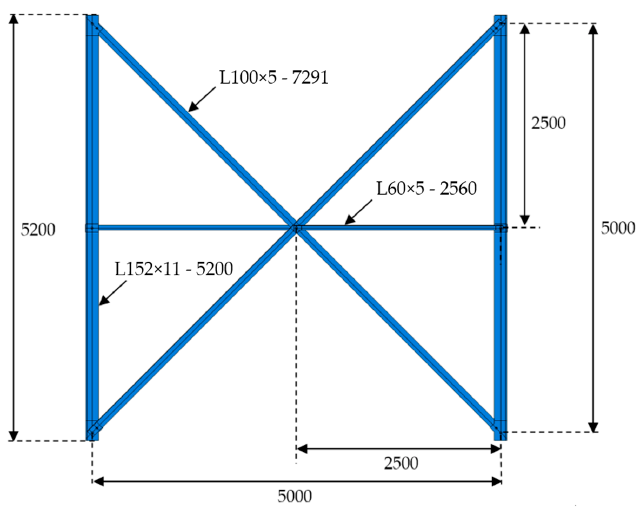
Figure 11. Planar sub-assembly geometry and dimensions.